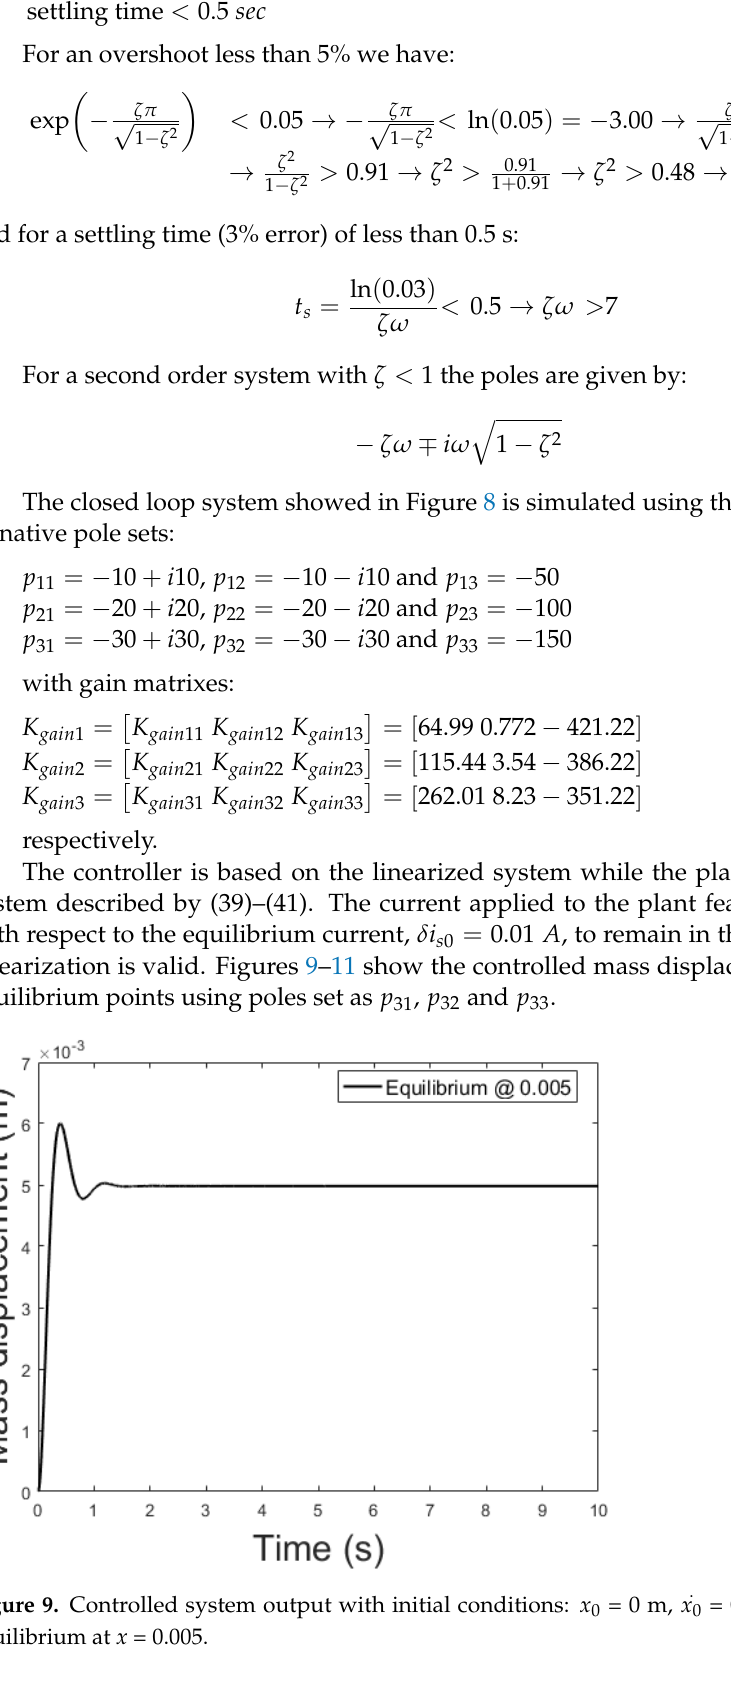
Figure 10. Controlled system output with initial conditions: 𝑥𝑥 0 = 0 𝑚𝑚 , 𝑥𝑥 0 ̇ = 0 𝑚𝑚 / 𝑠𝑠 , ψ = 0 Wb and equilibrium at x = 0.01.